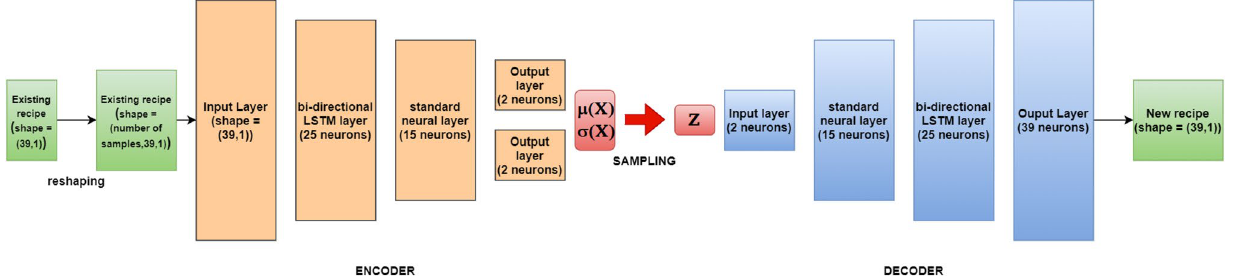
Fig. 2 Bi-directional LSTMs-based VAE